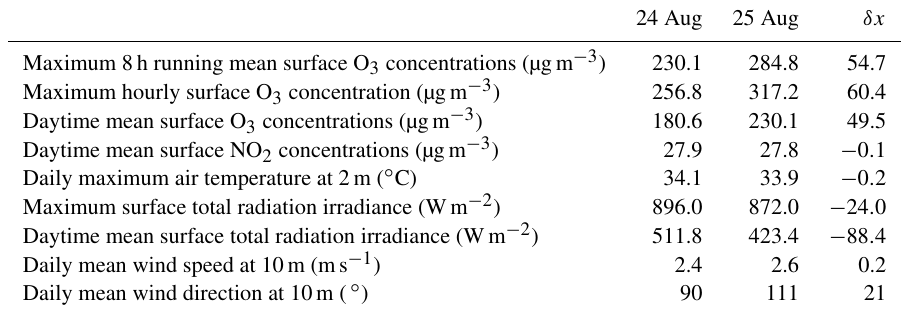
Figure 1. (a) The three nesting domains for the WRF-Chem simulation, (b) the topography with respect to altitude (m) and the locations of the six observation sites over the YRD region in the innermost domain, d03. Table 2. Meteorological and environmental elements observed at the NJ site in the western YRD from 24 to 25 August 2016 and their daily differences ( δx